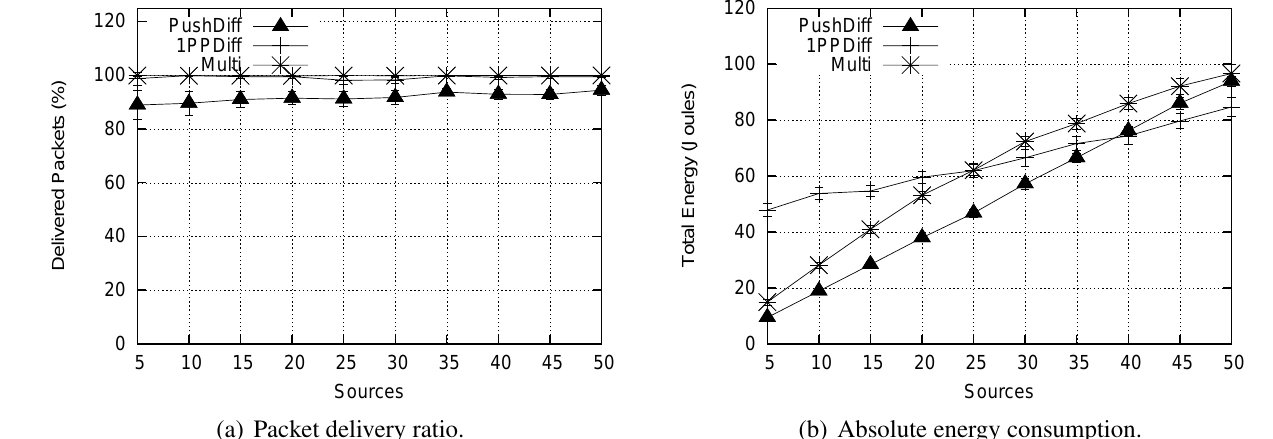
Figure 13. Comparison with threshold